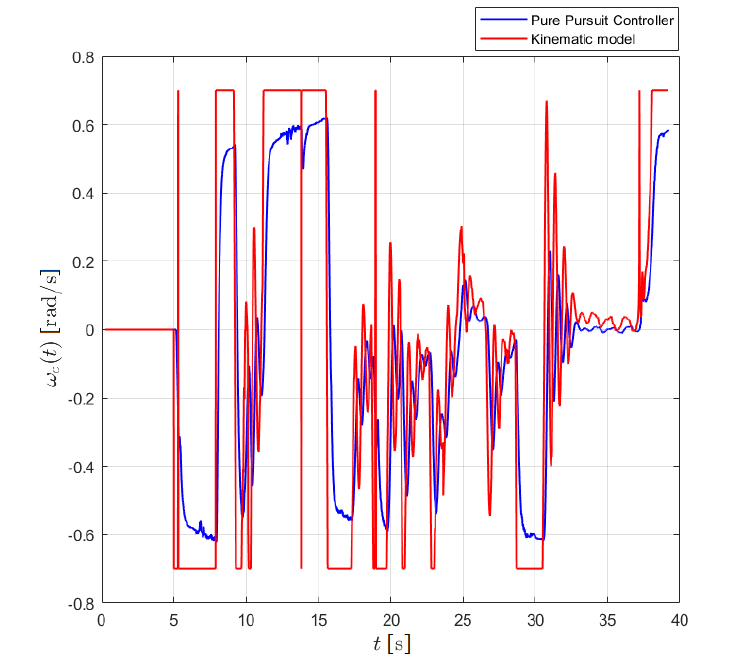
Figure 11. Angular velocity ω c ( t ) of the QBot 2e robot. The first generated map with the mapping of the path using the RRT star algorithm is presented below. In Figures 13 and 14, the linear and angular velocity of the robot are presented. They were determined on the basis of odometric data and the kinematic model.